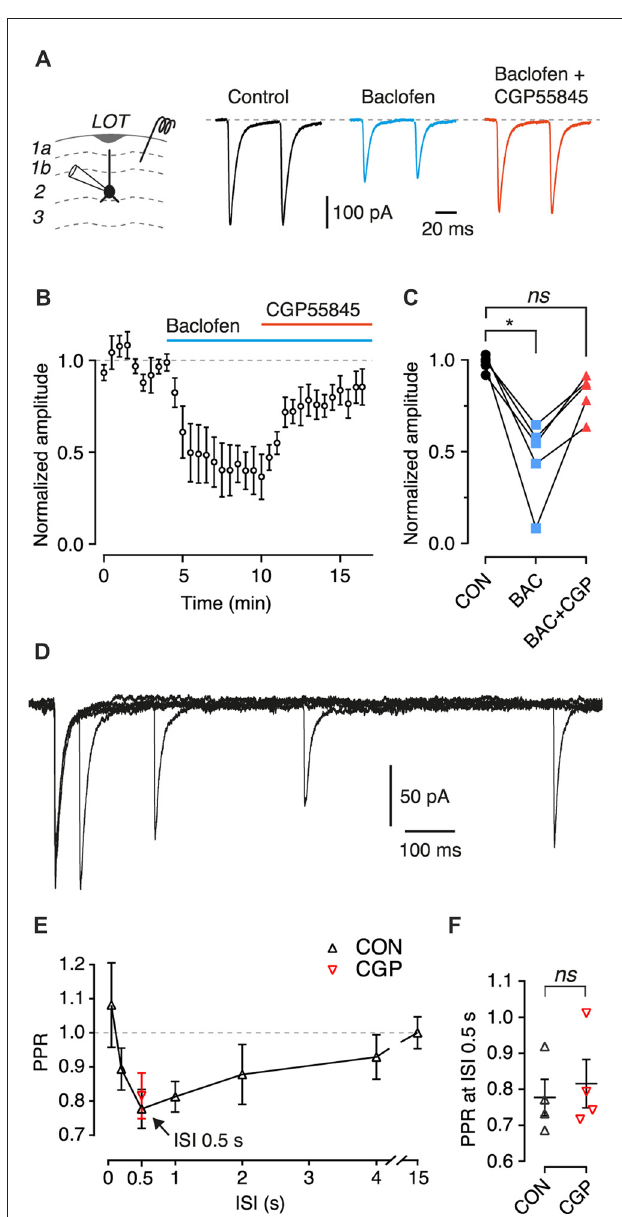
FIGURE 3 | Activation of presynaptic GABA B heteroreceptors inhibits EPSCs from associational inputs onto SP cells, but these receptors are not involved in paired-pulse depression. (A) Typical EPSCs recorded in an SP cell in response to paired-pulse stimulation (50 ms interstimulus interval, ISI) of layer 1b during control (black), in the presence of baclofen (100 µ M; blue) and baclofen + CGP55845 (5 µ M; red). Each trace is an average of 10 episodes. Stimulus artifacts have been blanked. (B) Mean EPSC amplitude, normalized to the mean amplitude during the control period, plotted vs. time. Baclofen (bath applied during the period shown by the blue bar) decreased the normalized EPSC amplitude, and addition of CGP55845 (application shown by the red bar) reversed this inhibition. Error bars are ± SEM. Data from n = 5 SP cells. (C) Summary data for (B) showing the normalized EPSC amplitude averaged over the control period (CON, 100–190 s), the period in baclofen (BAC, 400–490 s) and the period in baclofen + CGP55845 (BAC+CGP, 800–890 s). Symbols show means for individual cells ( n = 5 SP cells). (D) Typical data from ( Continued